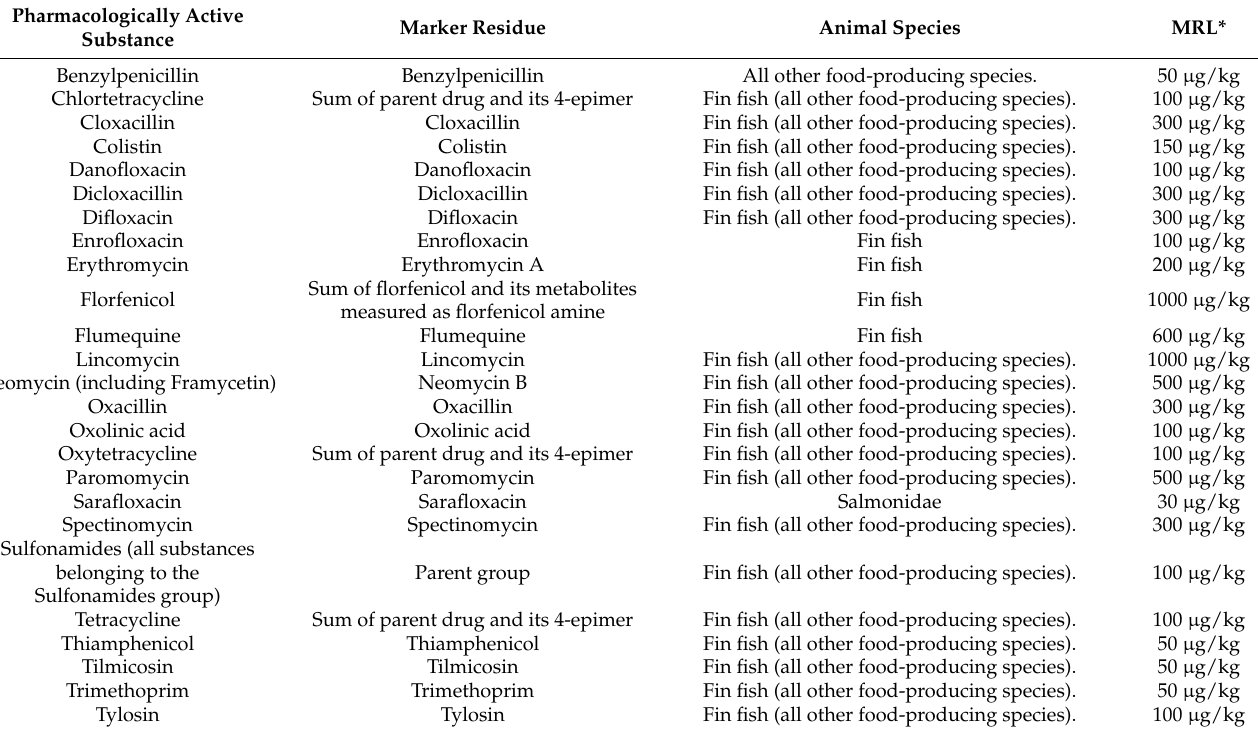
Table 1. Pharmacologically active substances and their classification regarding maximum residue limits (MRL) in foodstuffs of animal origin (from EU Reg. No. 37/2010). Pharmacologically Active